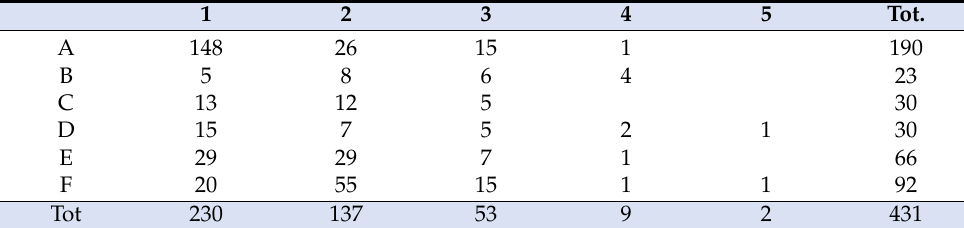
Table 4. Matrix of the relationship between the LR and TC.